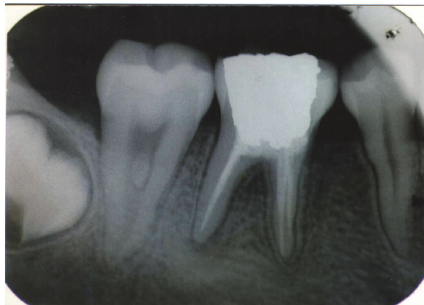
Figure 8: Radiograph showing healing after 9 months (46).